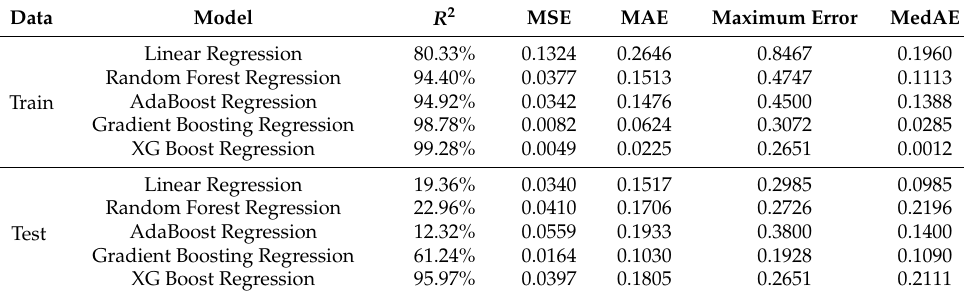
Table 3. Performance of the machine learning models on Mn (g/L)